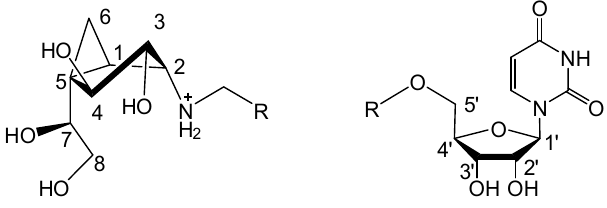
Figure 4. Numbering system used for NMR assignments.